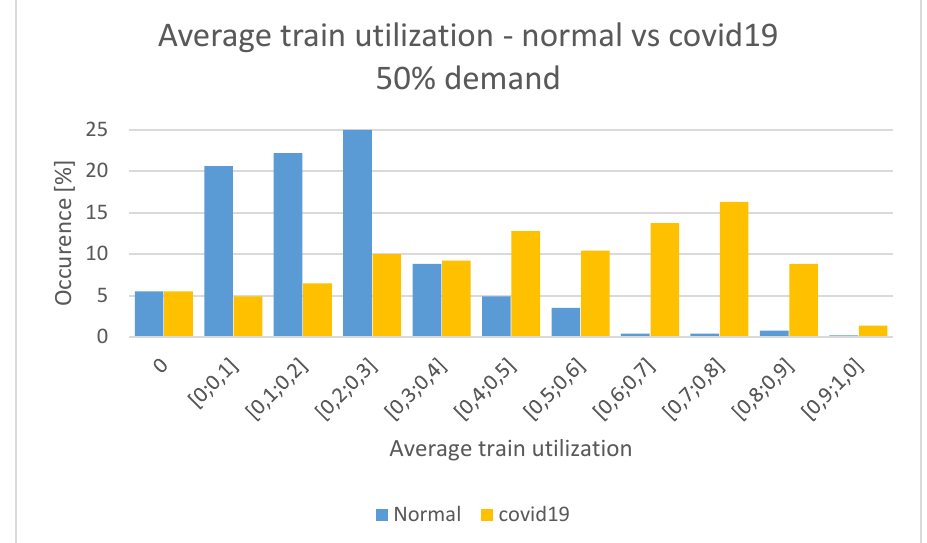
Figure 7. Average train utilization in normal and covid19 for 50% demand Finally, it is striking that for passengers demands of 25% of the original and higher, the system is expected to become more utilized based on its considered capacity than in normal conditions before covid19 as shown in Figure 8. Also, for 50% demand share every other train is maximally occupied at some point during its journey. For normal conditions (resulting in average (light blue) and max values (dark blue)), we can state that a well-designed system performs with approximately equal mean and median values (this holds for both max and average train utilization). For example, with 100% of demand, max train utilization reaches 0.53 (mean) and 0.51 (median). Instead, for covid19, such balanced mean vs median ratio holds only for the demand shares of 5 and 25% while for bigger demand shares, the max utilization grows at a much higher rate. This represents that the system capacity becomes saturated pretty quickly. Therefore, it can be concluded that the system under covid19 can perform "well" on the level of normal peak hours only up to 25% of normal demand. In addition, looking at the ratio of trains with occupancy bigger than 0.90 at any link, these numbers are even more remarkable (Figure 9). In particular, for covid19, about 67% of all trains would be least 90% full (max link utilization of 0.9) at some point of its journey . While for normal, these numbers reach 0.20 only. Therefore, any demand of 25% and higher would mean experiencing higher train use and more crowding than in pre-covid19 conditions. This can clearly have significant implications on transport planning and